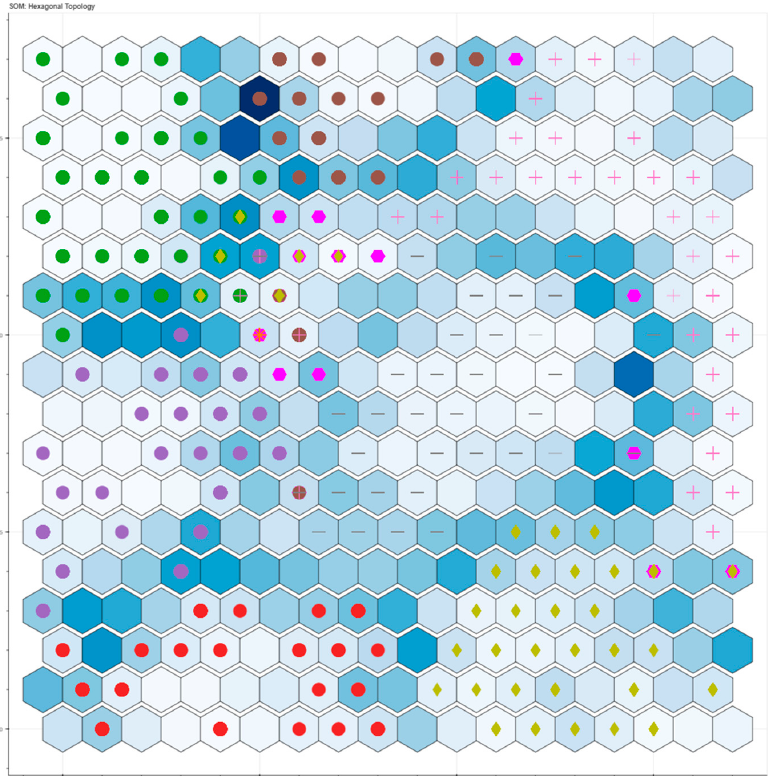
Figure 10. The output map of input data. The figure legend can be consulted in Table 4.